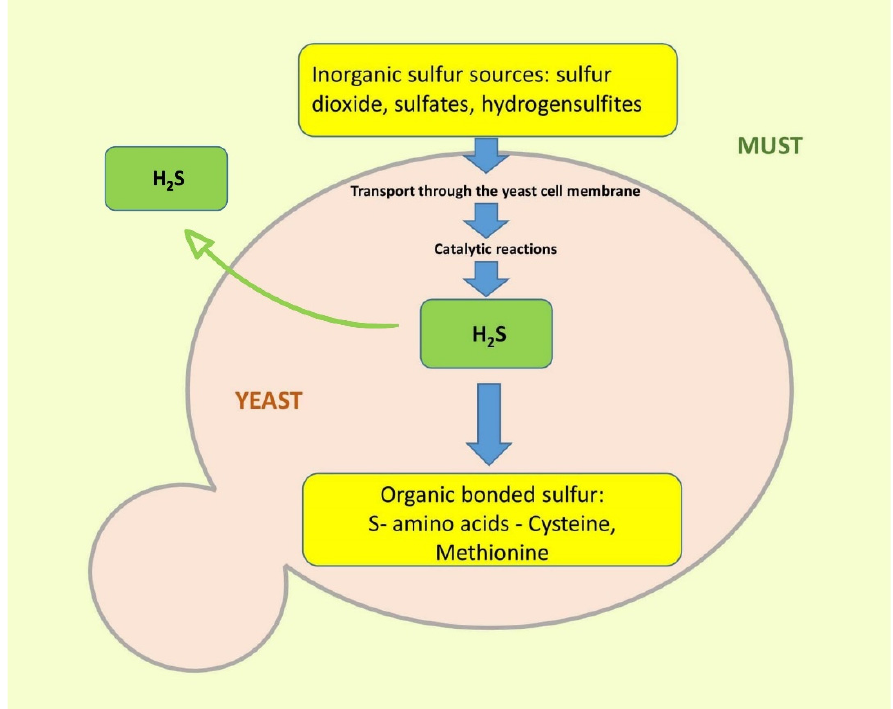
Figure 1. Schematic sulfur reduction pathway and formation of amino acid biosynthesis in S. cerevisiae , based on [34,38,40].